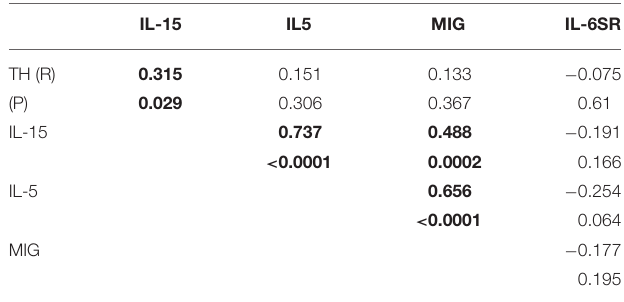
TABLE 5 | Correlation between significant protein measures and with TH in substantia